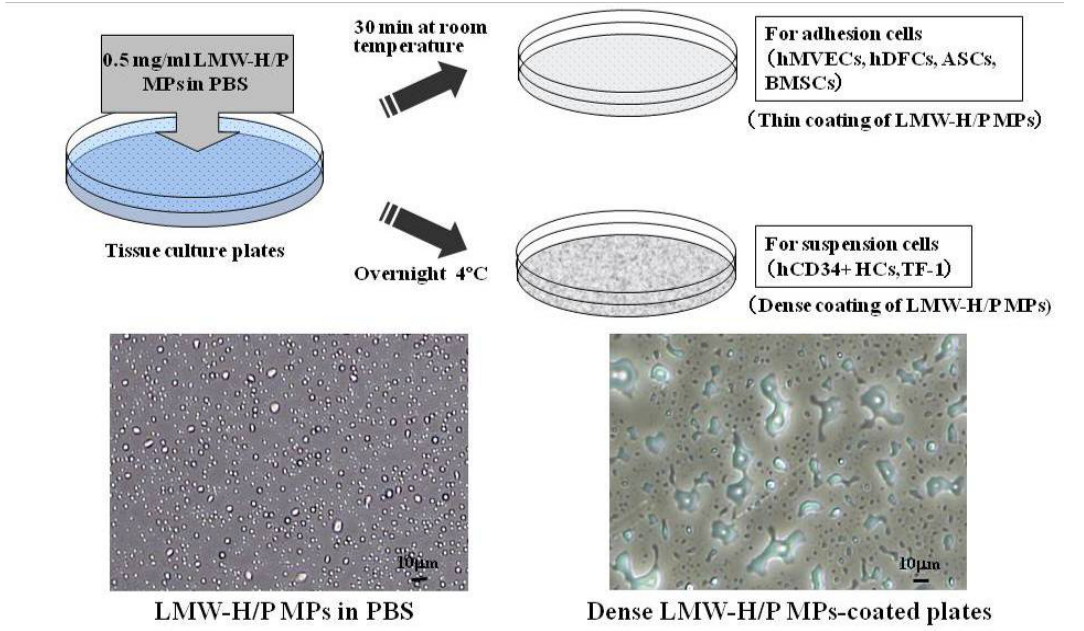
Figure 7. Preparation of F/P MPs-coated